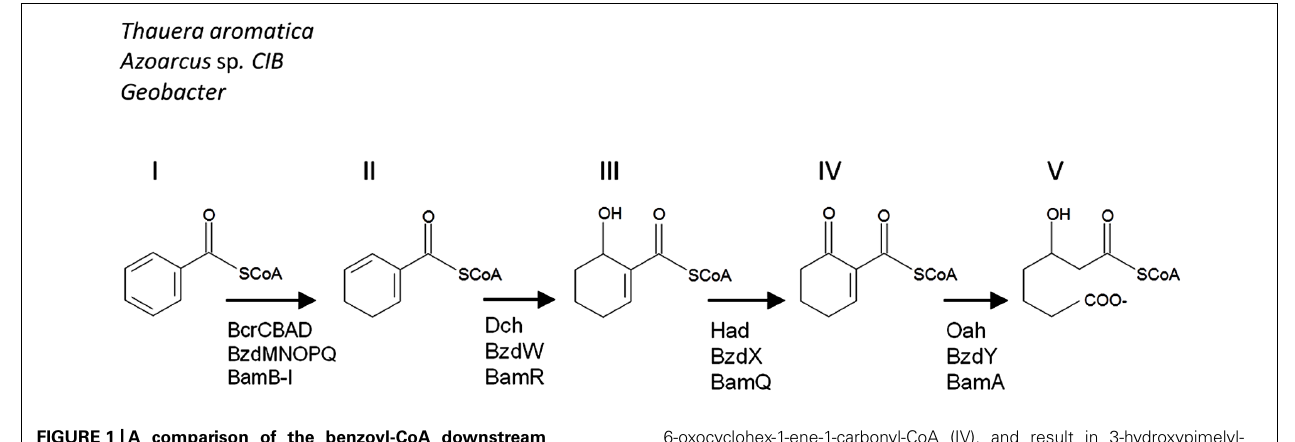
FIGURE 1 |A comparison of the benzoyl-CoA downstream metabolic pathways. Benzoyl-CoA (I) is dearomatized to cyclohexa- 1,5-diene-1-carbonyl-CoA (II). For Thauera , Azoarcus , and Geobacter the metabolites include 6-hydroxycyclohex-1-ene-1-carbonyl-CoA (III),